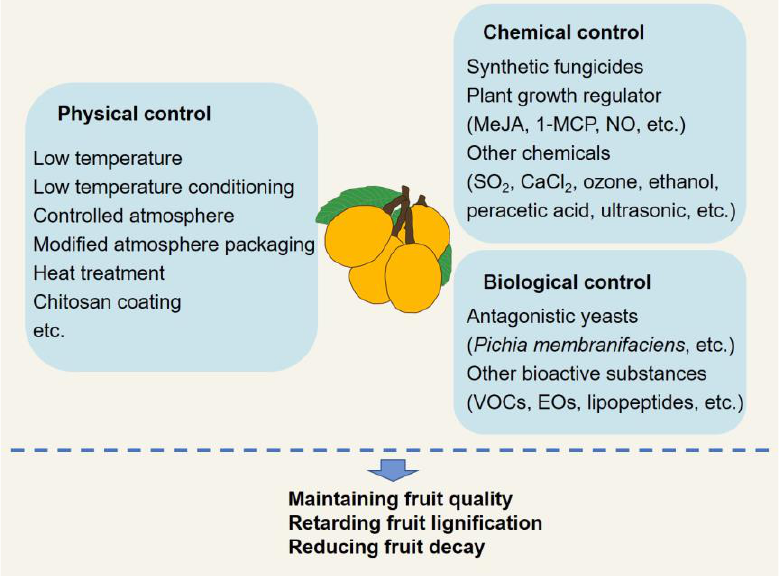
Figure 3. Postharvest technologies of loquat fruit.